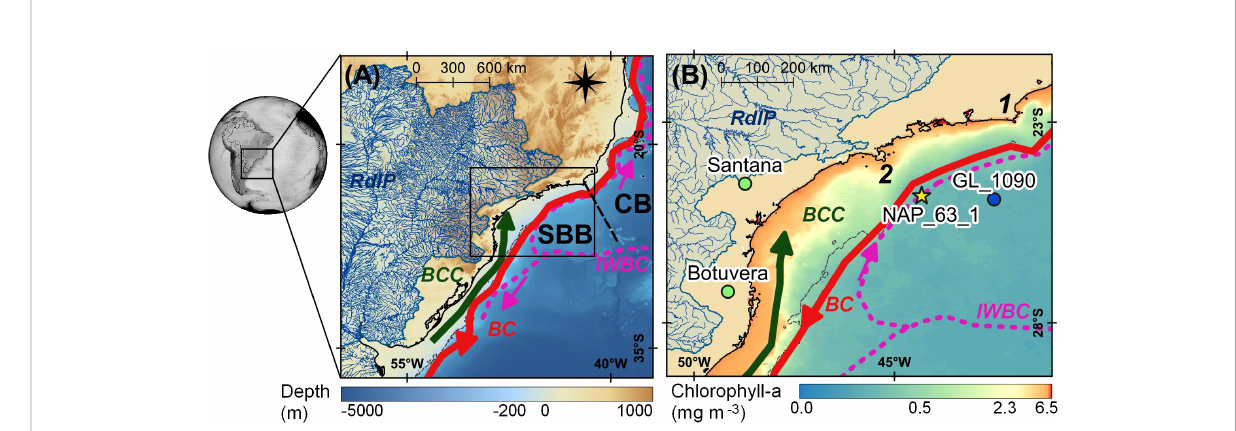
FIGURE 1 (A) Indication of the main ocean currents in the SW Atlantic as well as the location of Campos Basin (CB) and South Brazil Bight (SBB) separated by the black dashed line. The black rectangle is displayed in map B. (B) Map highlighting the SBB with the location of sediment core NAP 63-1 (yellow star), GL-1090 (blue circle), and the speleothem sites (green circles) used in the discussion. The gray dashed line indicates the continental shelf break. Current names, BC, Brazil Current; BCC, Brazil Coastal Current; IWBC, Intermediate Western Boundary Current. Geographical features: 1 - Cabo Frio; 2 - São Sebastião